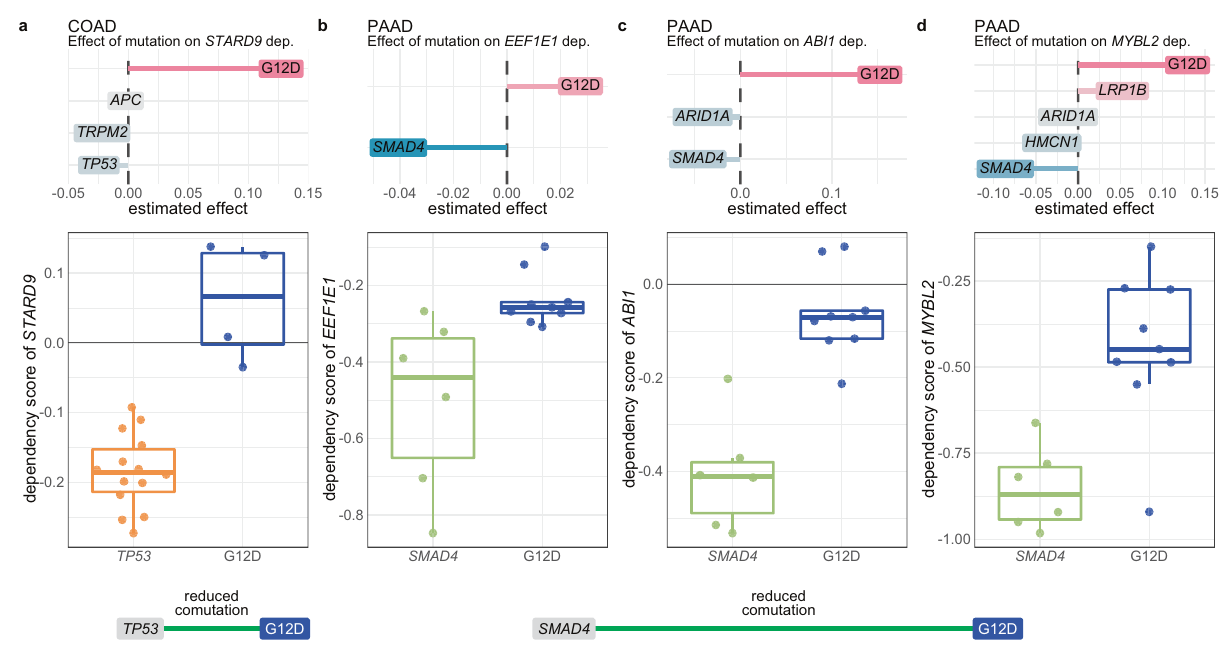
Fig. 5 Some dependency interactions can be explained by comutation events. a The nonzero coef fi cients for the model of STARD9 dependency in COAD cell lines regressed on KRAS G12D (versus all other KRAS alleles) and its comutation interactors (top), and the actual dependency scores for KRAS G12D mutant and TP53 -mutant cell lines (bottom). Cell lines without either mutation or with both are not shown. KRAS G12D has reduced comutation with TP53 in COAD. b – d The nonzero coef fi cients for the models of b EEF1E1 , c ABL1 , and d MYBL2 dependency in PAAD cell lines regressed on KRAS G12D (versus all other KRAS alleles) and its comutation interactors (top), and the actual dependency scores for KRAS G12D mutant and SMAD4 mutant cell lines (bottom). Cell lines without either mutation or with both are not shown. KRAS G12D has reduced comutation with SMAD4 in PAAD. For the box plots, the box demarcations represent the 25th, 50th, and 75th percentiles, and the whiskers extend from the box to the largest and smallest data points at most 1.5 times the interquartile range away from the median. n = 23 biologically independent COAD cell lines, and n = 23 biologically independent PAAD cell lines. Source data are provided in the Source data fi